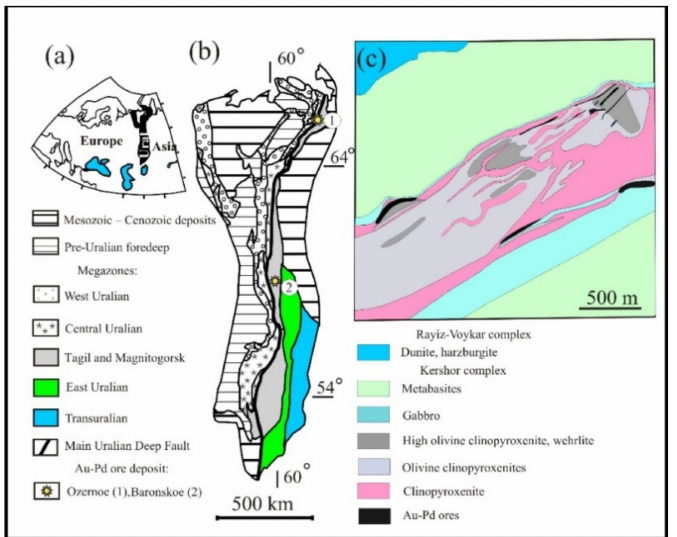
Figure 1. ( a ) Geographic location of the Urals on the Europe–Asia border; ( b ) position of Baronsky type objects in the tectonic structures of the Urals (modified from [13]) (on the right); ( c ) geologic structure and setting of gold–palladium mineralization at the Dzelyatyshor